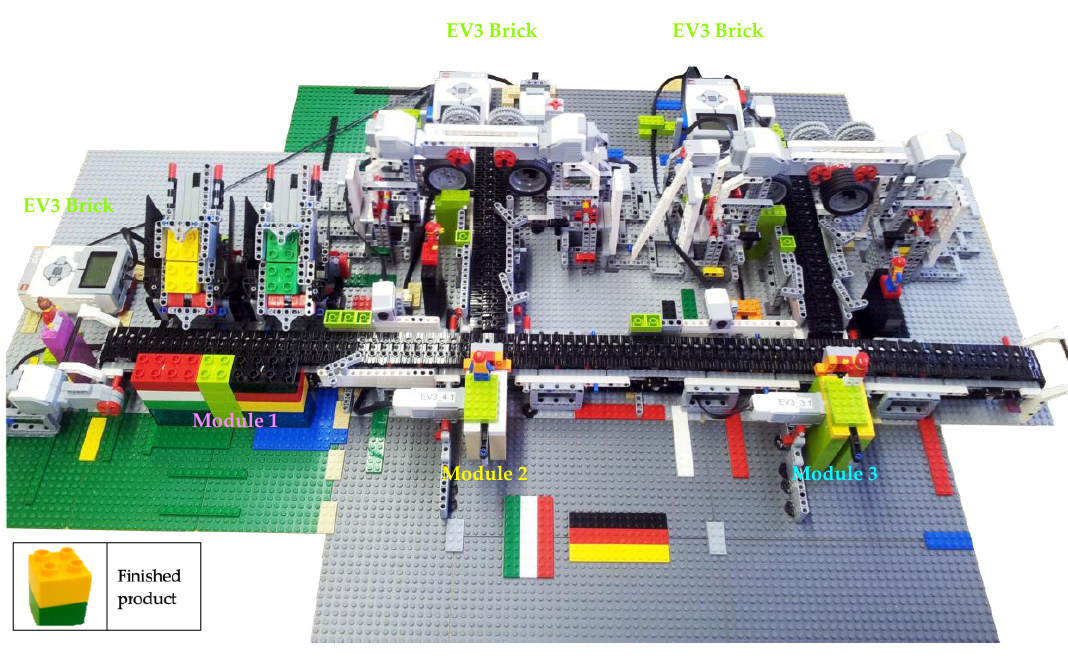
Figure 2. Lego ® Mindstorms ® EV3 prototype .